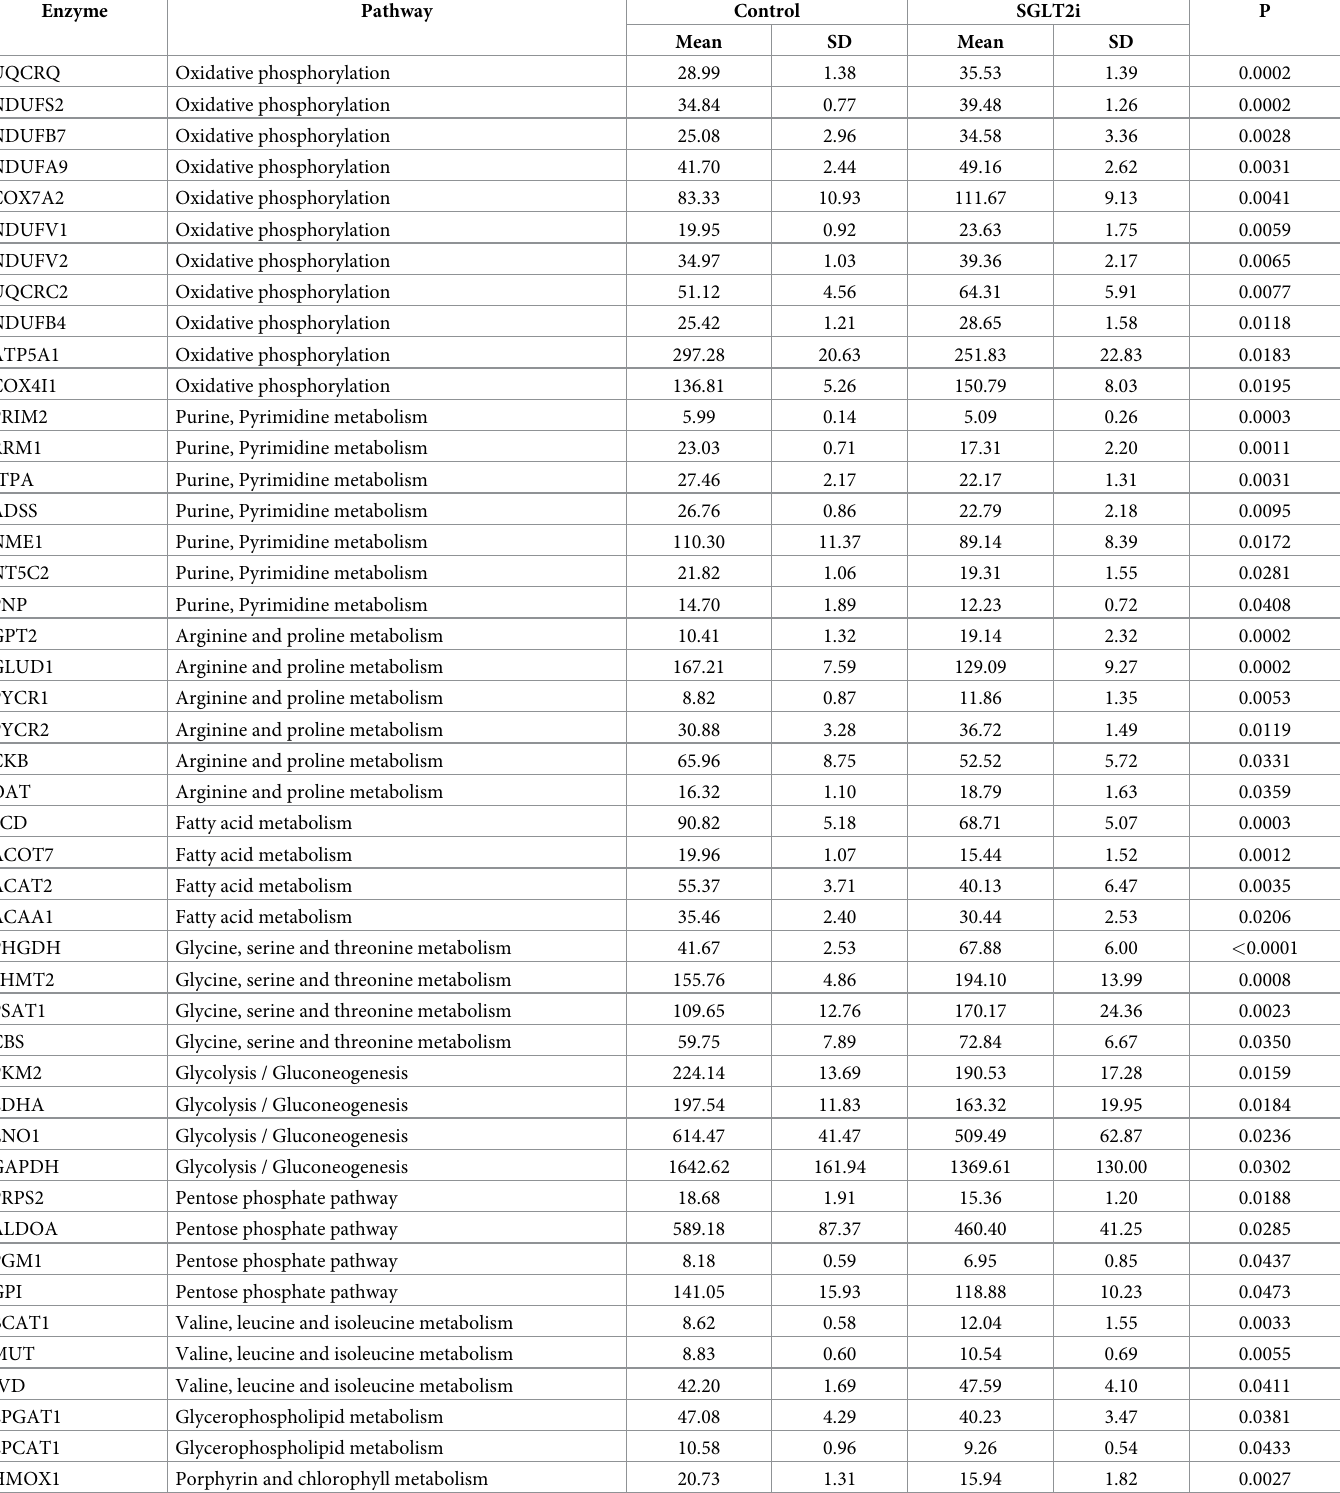
Table 1. Effects of CANA on expression level of metabolic enzymes by iMPAQT assay. Enzyme Pathway UQCRQ